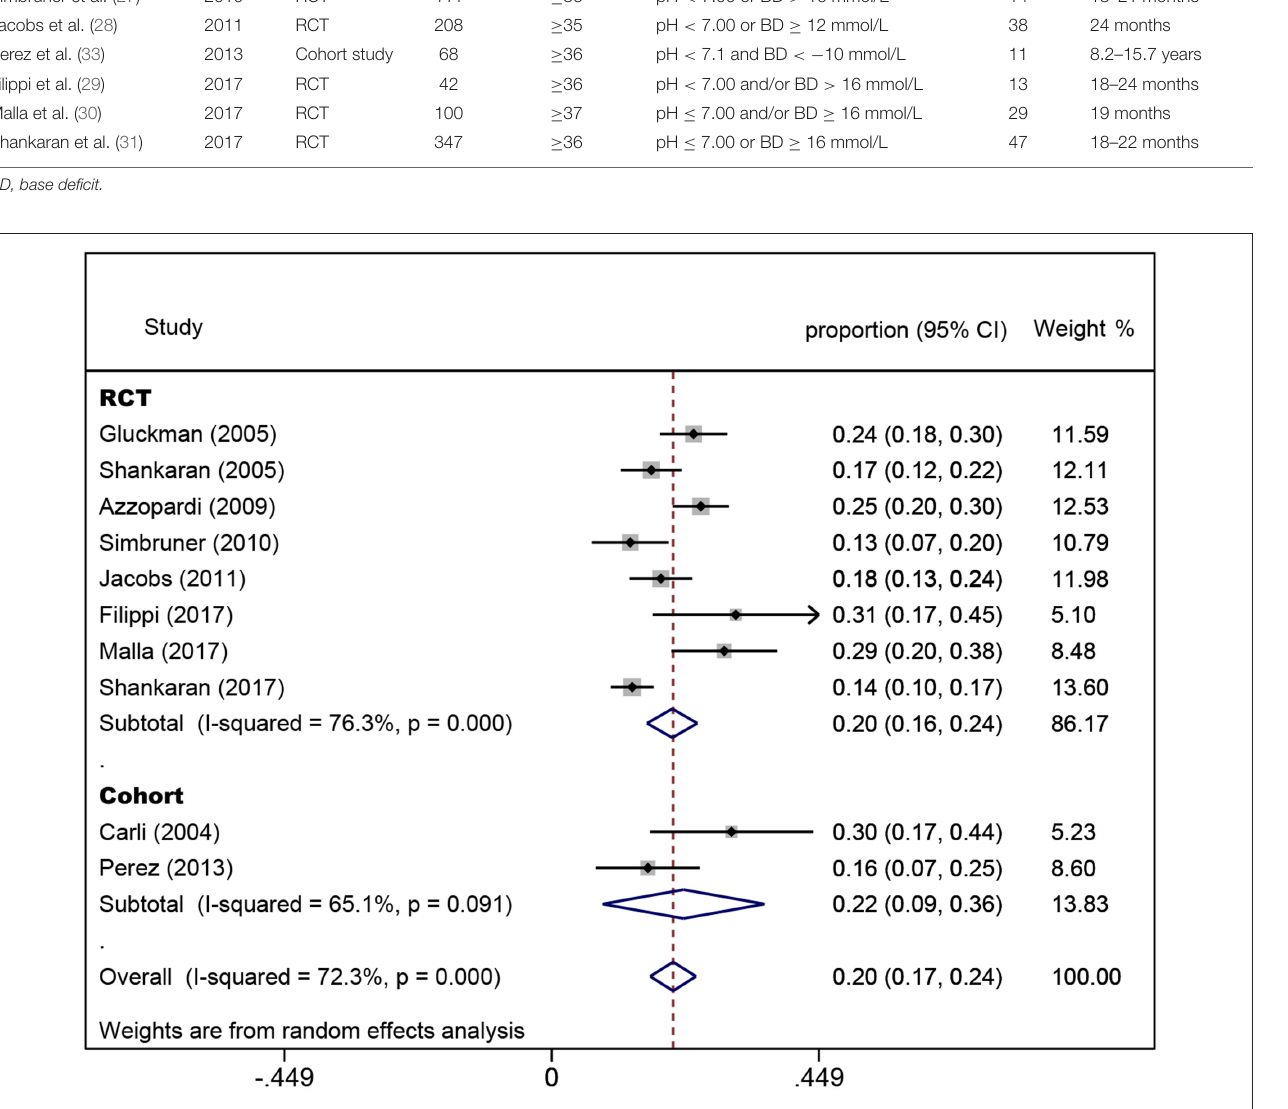
FIGURE 2 | Forest plot of the pooled rate of cerebral palsy. The solid diamonds and horizontal solid lines represent the proportions and 95% CIs of each included study. The size of the gray area indicates the study-specific statistical weight. The hollow diamonds show the pooled proportions and 95% CIs of each group and the overall population. The vertical red dotted line shows the combined effect